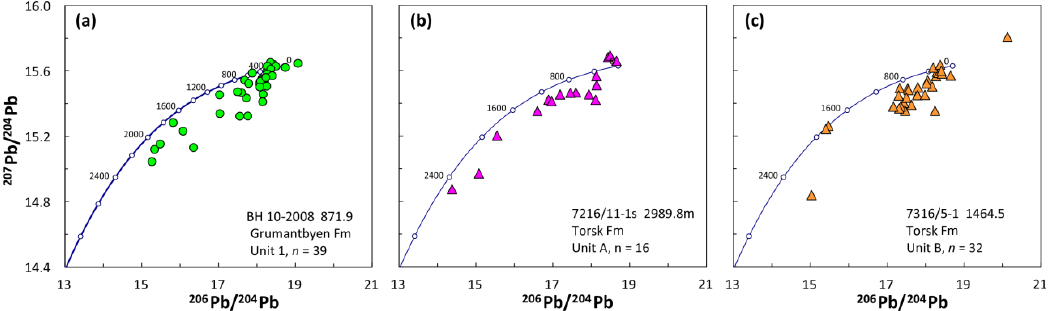
Figure 7. Detrital K feldspar Pb isotopic data for ( a ) Unit 1 of the Grumantbyen Formation from wellbor BH 10-2008, ( b ) Unit A of the Torsk Formation from wellbore 7216/11-1S and ( c ) Unit B of the Torsk Formation from wellbore 7316/5-1. In each plot the curve represents the evolution of average continental crust, taken from Stacey and Kramers [59].